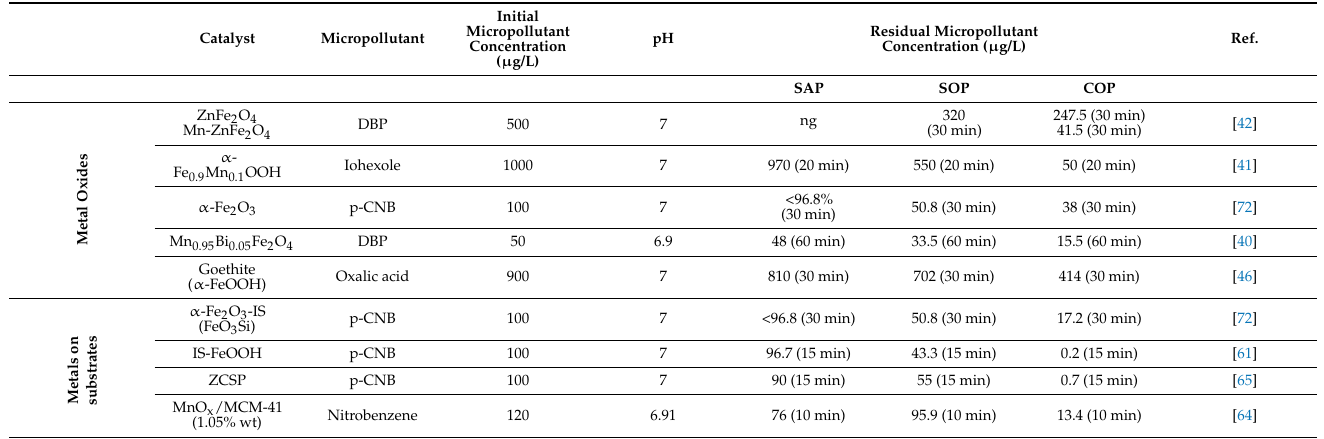
Table 5. Literature studies regarding the removal of micropollutants with initial concentrations ≤ 1 mg/L by the application of heterogeneous catalytic